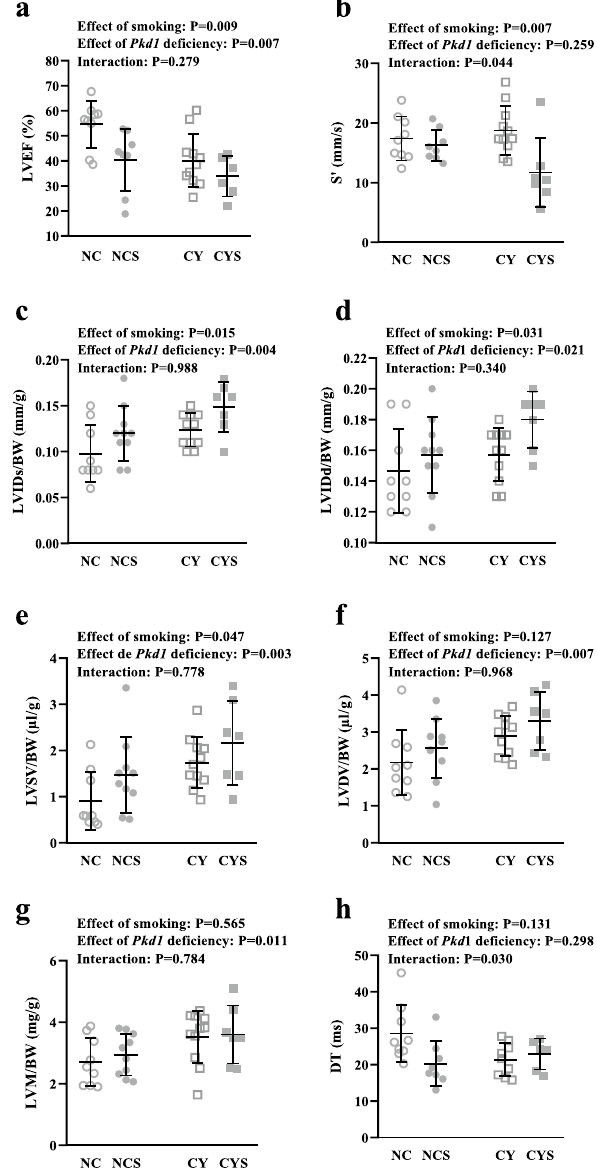
Figure 3. Analyses of the effects of smoking and Pkd1 deficiency in LVEF ( a ), S’ ( b ), LVIDs/BW ( c ), LVIDd/ BW ( d ), LVSV/BW ( e ), LVDV/BW ( f ), LVM/BW ( g ) and DT ( h ) on NC, NCS, CY and CYS mice. These data were analyzed using two-way analysis of